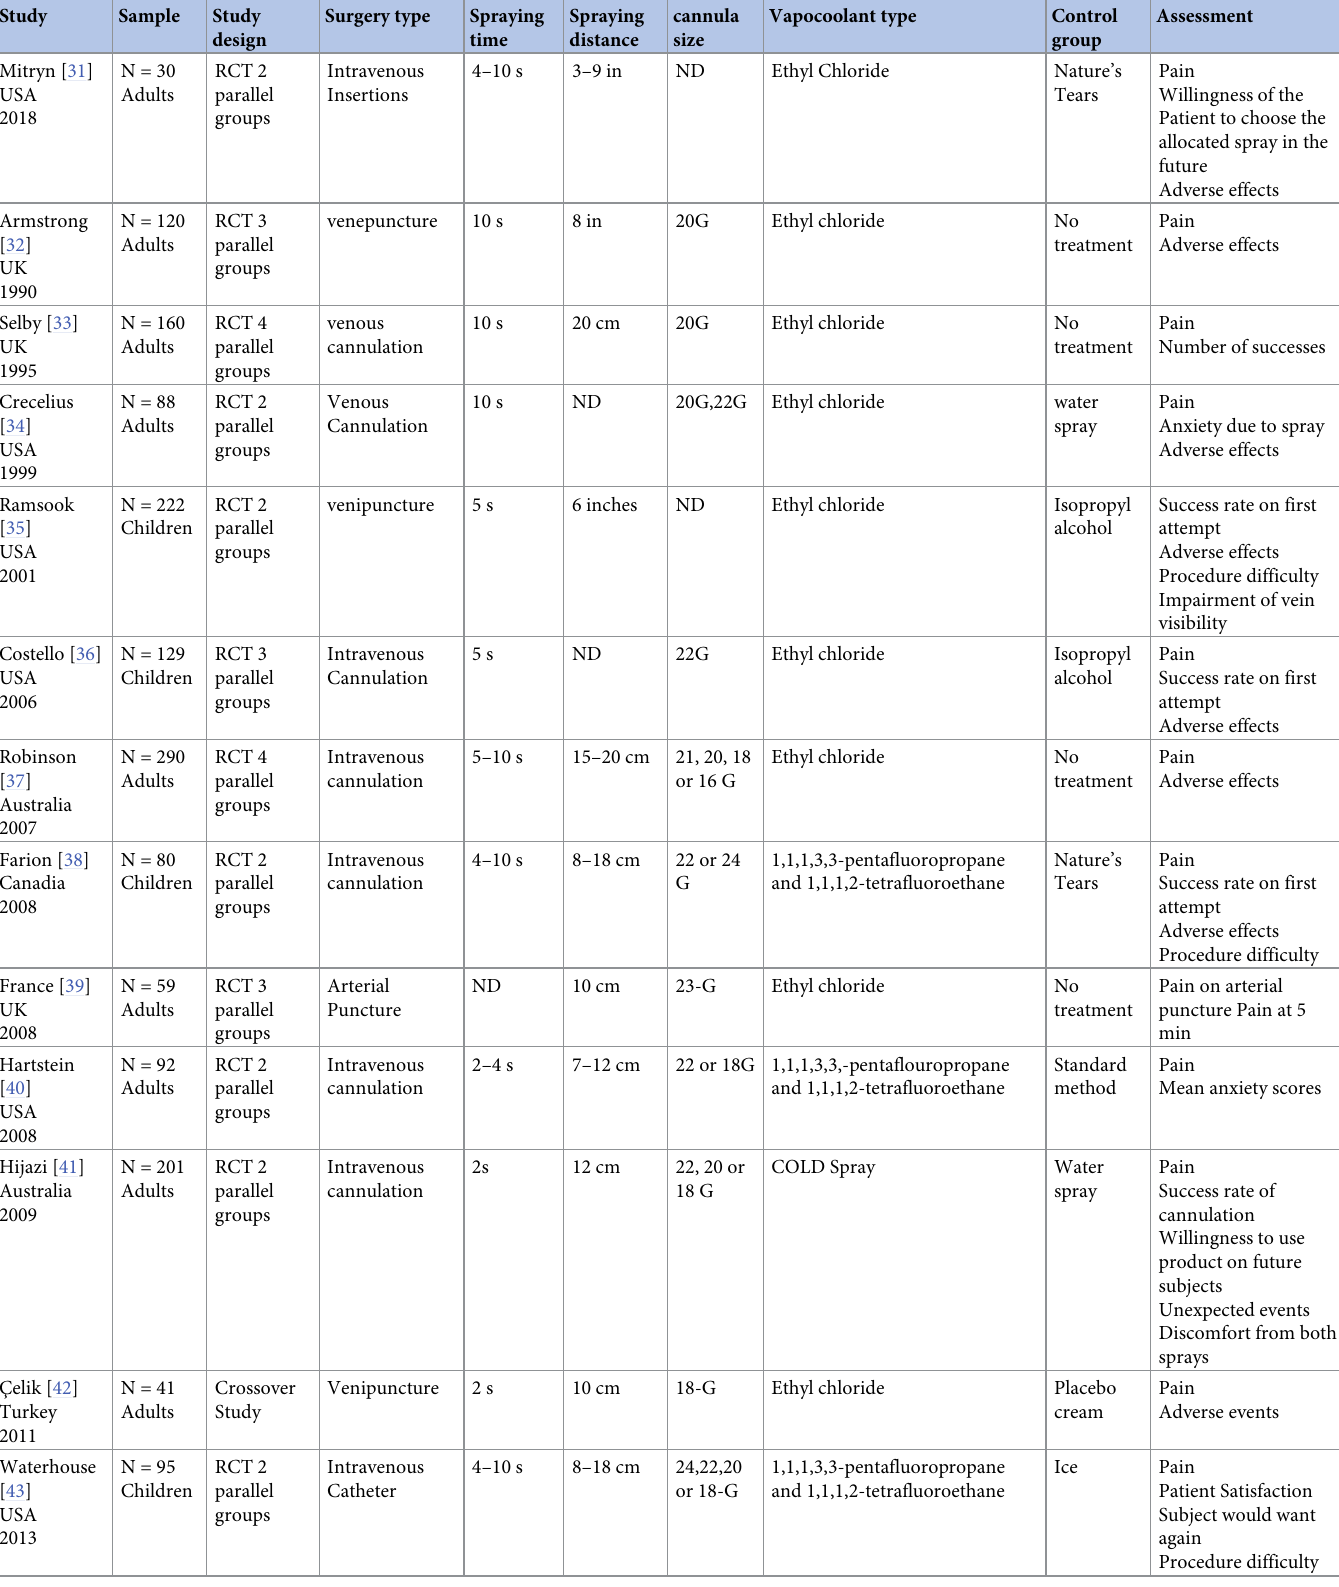
Table 1. General description of studies included in the